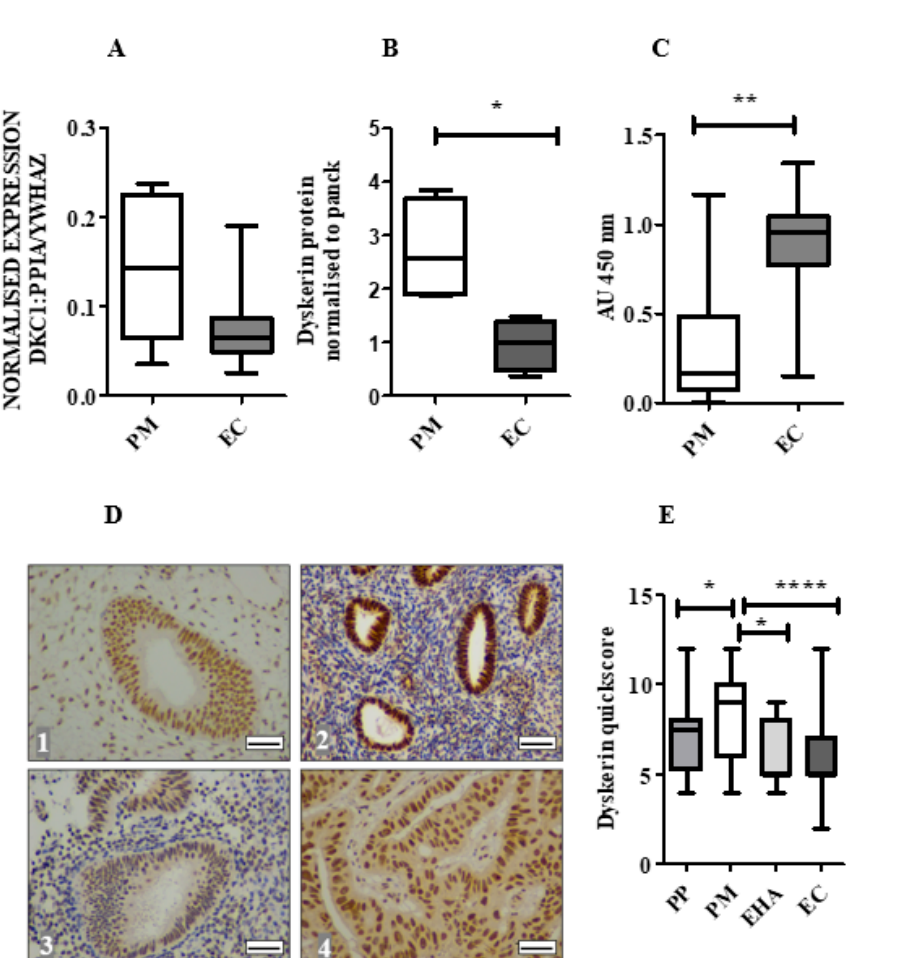
Figure 2. DKC1 mRNA and dyskerin protein in human endometrium. ( A ) DKC1 mRNA is normalised to geometric means of PPIA and YWHAZ and measured by qPCR in endometrial tissue samples: healthy postmenopausal (PM) ( n = 6) and endometrial cancer (EC) ( n = 22). Mann-Whitney test. ( B ) The amount of dyskerin protein was evaluated by immuno-blotting in healthy PM ( n = 4) and EC ( n = 4), Glyceraldehyde 3-Phosphate Dehydrogenase (GAPDH) was used to ensure equal loading of protein. Dyskerin protein levels in epithelial cells of tissue samples were analysed by normalising to pancytokeratin (panck). Mann-Whitney test, * p < 0.05. ( C ) Telomerase activity (TA) in healthy endometrial PM ( n = 6) and EC ( n = 32) was measured using a Telomere Repeat Amplification Protocol (TRAP) assay, Mann-Whitney test, ** p < 0.01. AU: arbitrary units ( D ) Representative microphotographs illustrating dyskerin IHC staining at the cellular level in endometrial samples in ( 1 ) normal proliferative phase (PP) endometrium, ( 2 ) healthy PM endometrium, ( 3 ) endometrial hyperplasia with cytological atypia (EHA) and ( 4 ) EC. Positive staining appears brown. Magnification 400×. Scale bar 50 μ m. ( E ) Immunostaining quickscores for dyskerin protein in the human endometrium, healthy PP ( n = 16), PM ( n = 30), EHA ( n = 15), EC ( n = 109). Kruskal-Wallis test, * p < 0.05, **** p < 0.0001.